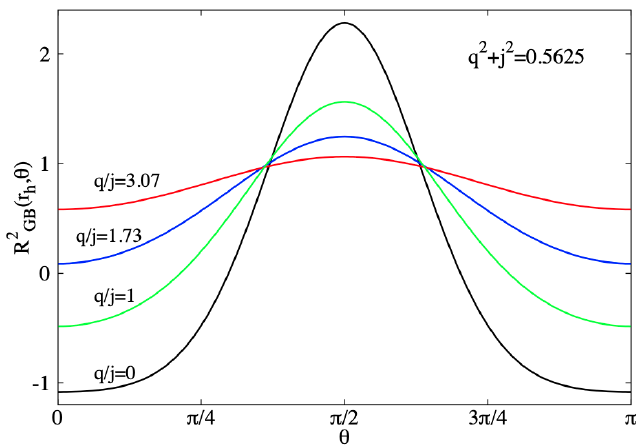
Figure 4. The GB invariant at the horizon (in units of mass) as a function of the θ − coordinate for several Kerr-Newman